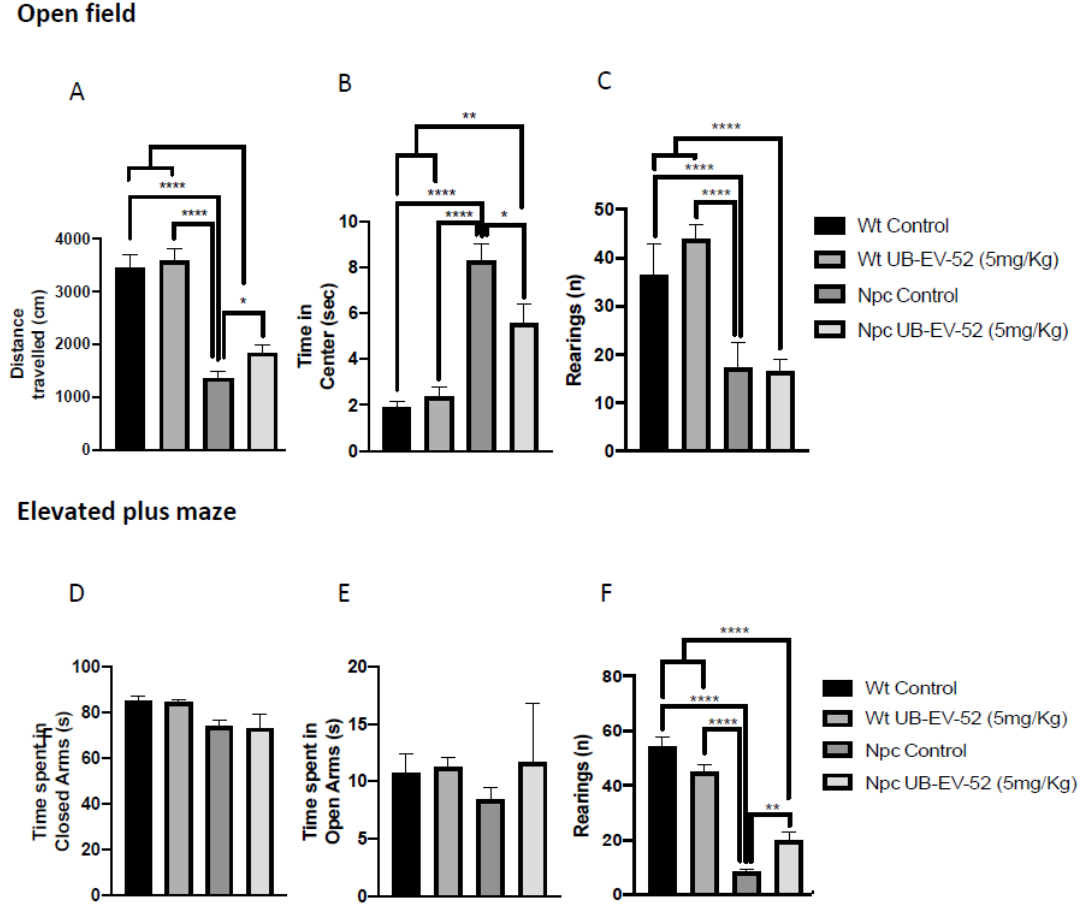
Figure 2. OFT results. Distance traveled in both females and males ( A ), time spent in the central zone ( B ), rearings ( C ). EPM results: time spent in open arms ( D ), time spent in closed arms ( E ), rearings ( F ). Values represented are mean ± standard error of the mean (SEM); n = 48 (Wt control n = 12, Wt UB-EV-52 (5 mg/kg) n = 12, Npc control n = 12, and Npc UB-EV-52 (5 mg/kg) = 12). * p < 0.05; ** p < 0.01; **** p < 0.0001.